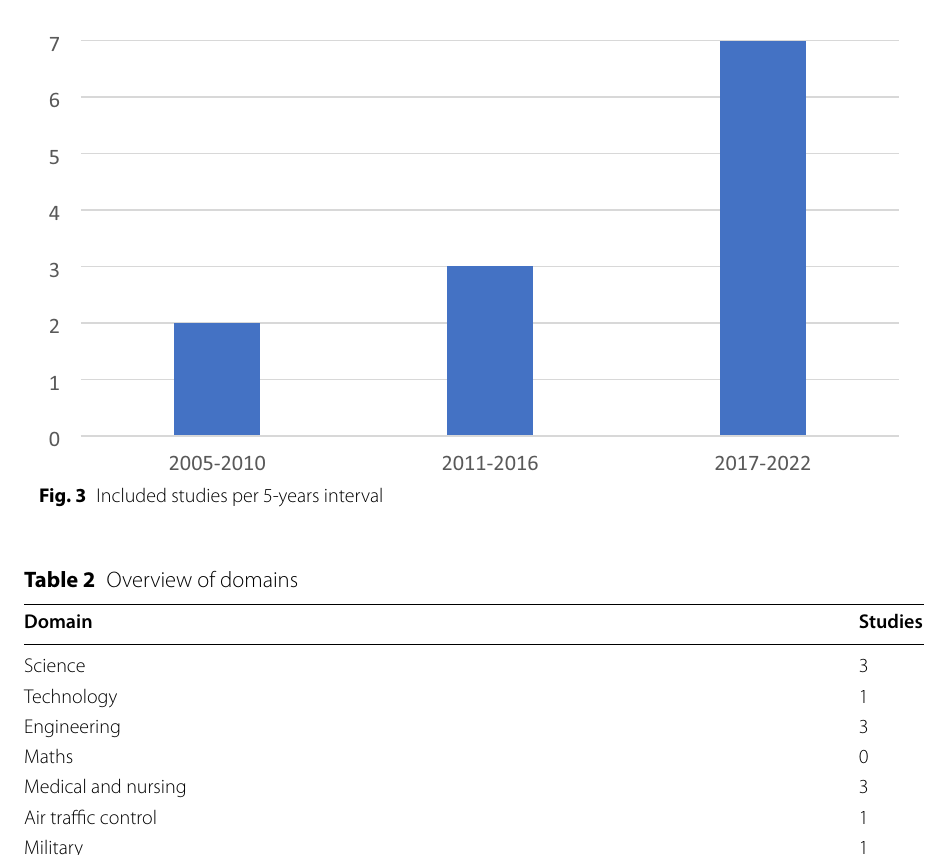
Inclusion—Objectives of analysis and results